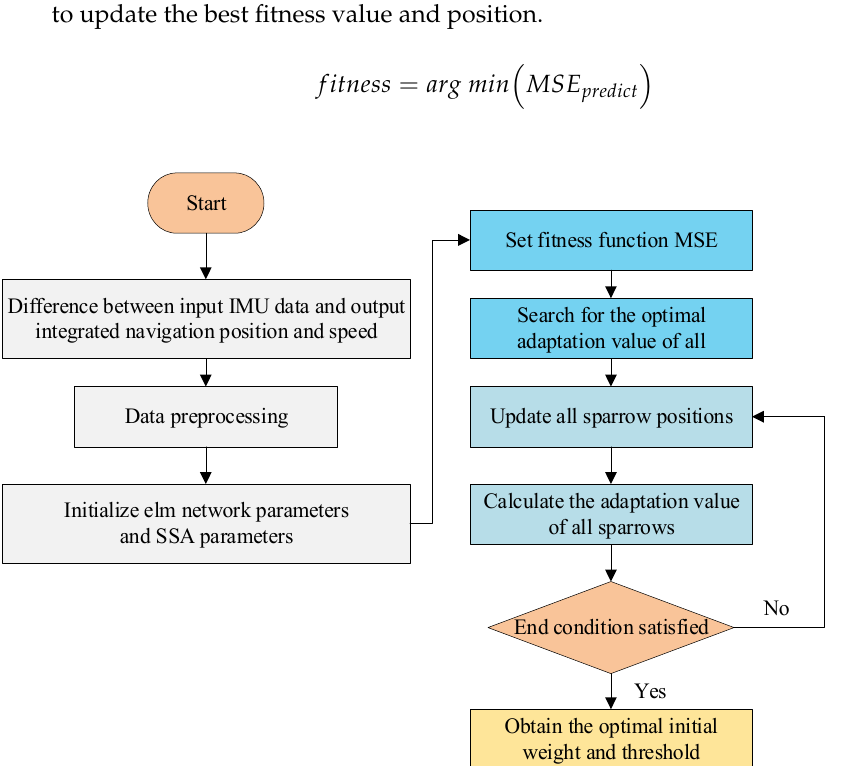
Figure 6. Sparrow search algorithm (SSA) ‐ ELM algorithm flow chart.